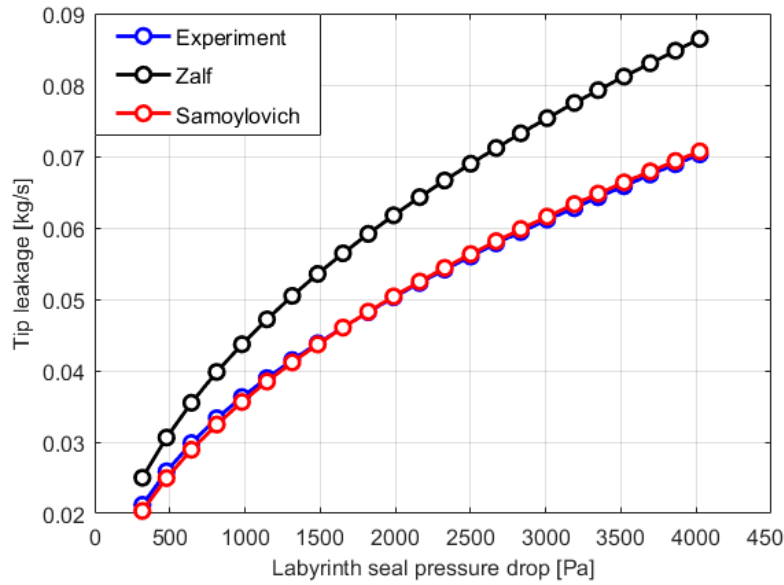
Figure 9. Comparison of measured data with analytical models.